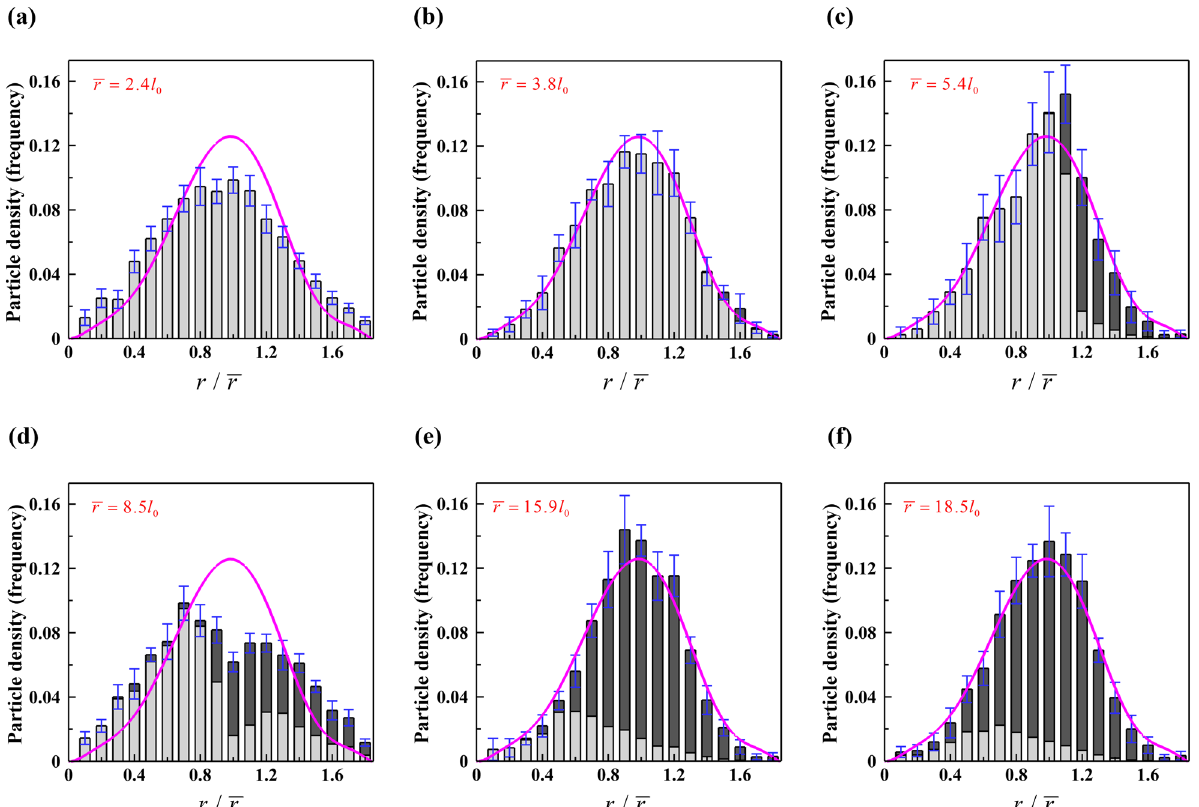
→ 0.5 l 0 0 ), d with Fig. 4a ( l 0 ), and e , f with Fig. 5b ( l 0 roughly represents fraction of semi-coherent particles in that bin. The error bar is set similar to Fig. 3b.